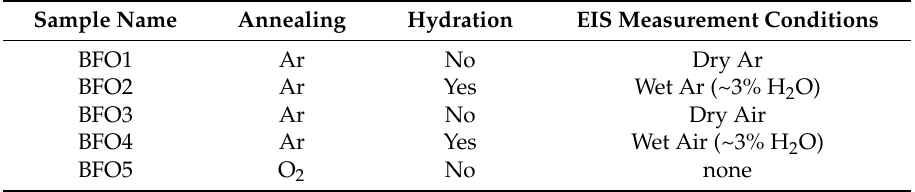
Table 1. Summary of all samples including treatments and EIS measurement